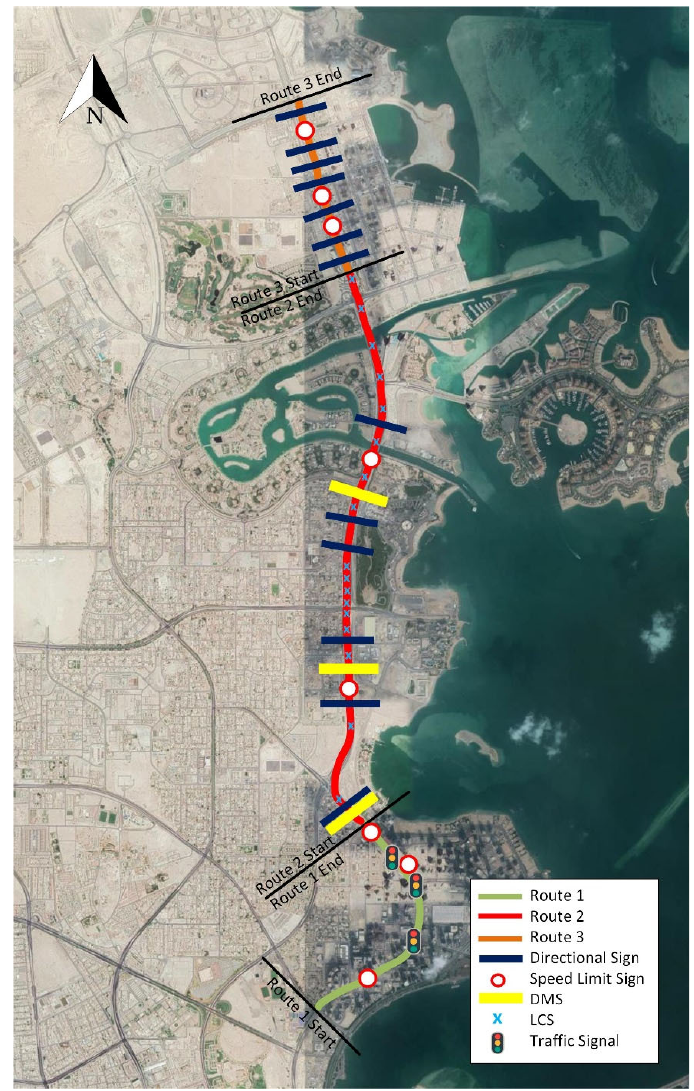
Figure 2. Driving experiment routes.